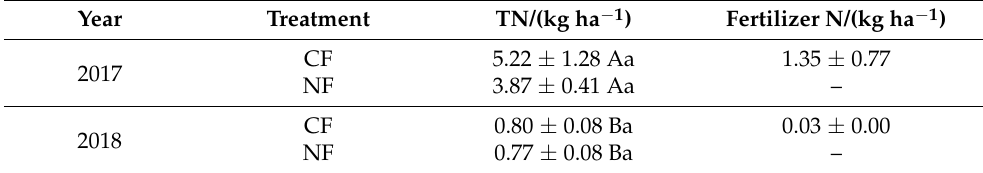
Table 6. Loss amount of total N and fertilizer N via sediment in peanut-growing